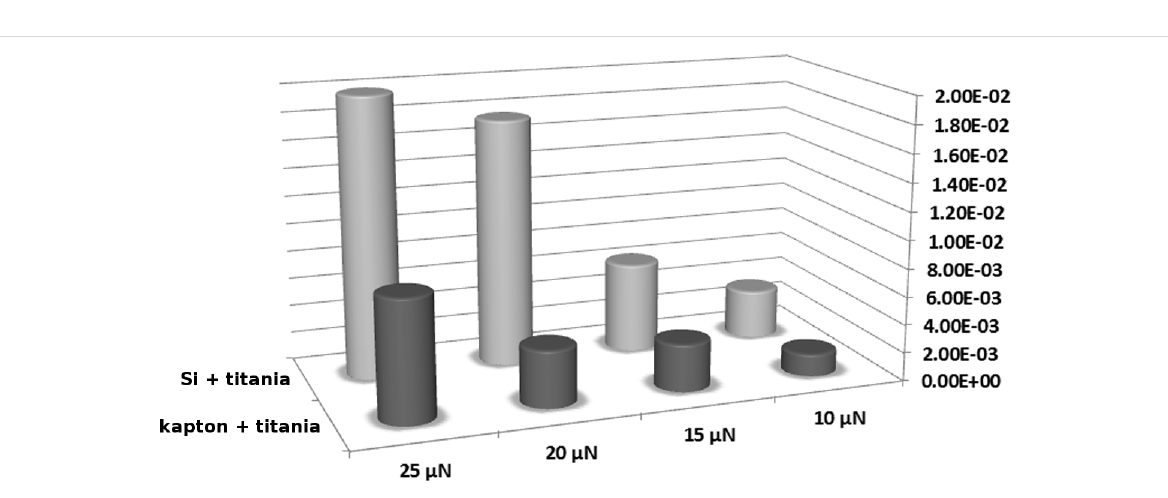
PC: for the latter two, the profile is sharp, and defined by the shape of the tip. In the presence of PDMS, wear is inhibited at the lower loads but when a wear track appears at the higher loads it is significantly broader. This can be understood from